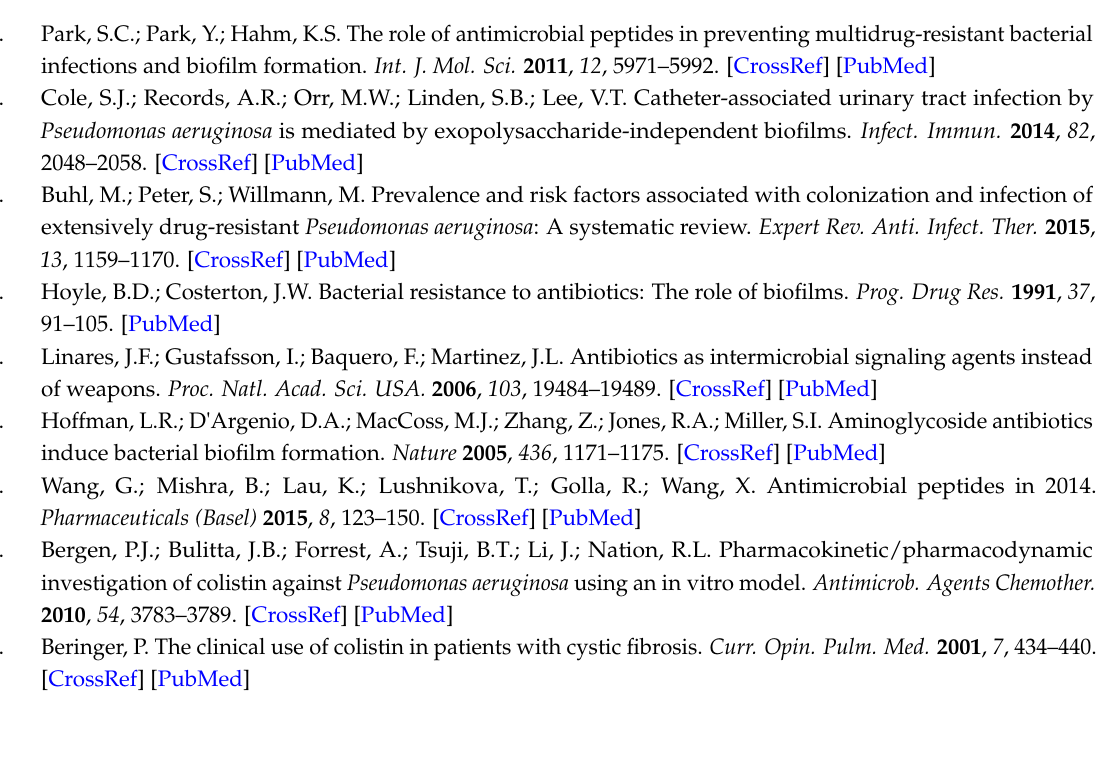
Table S1: Antimicrobial activities of the selected peptides against various